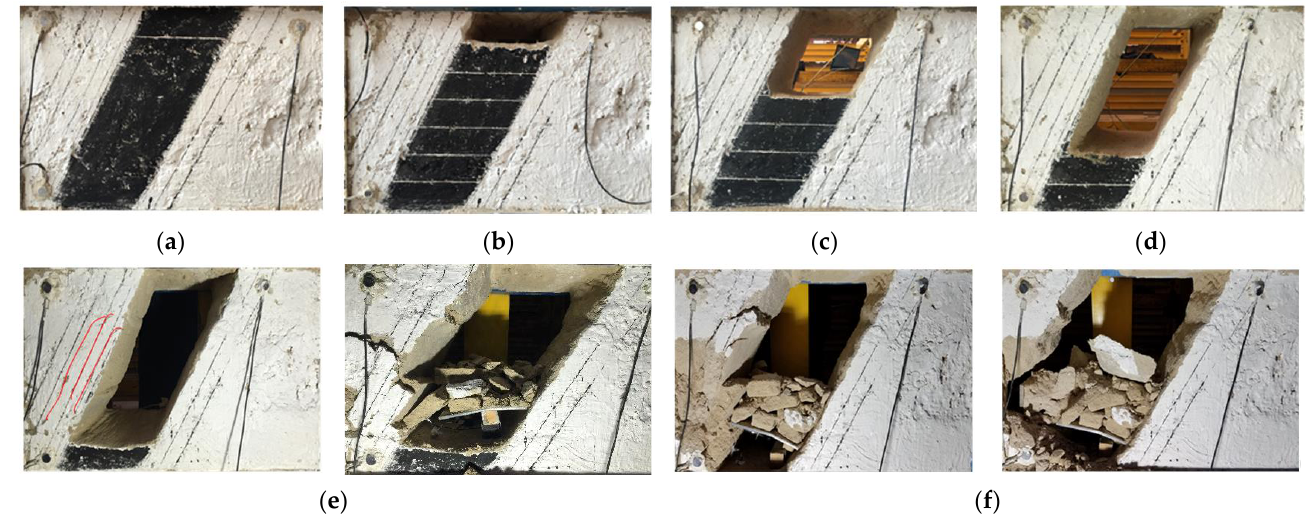
Figure 5. Model excavation process and phenomenon. ( a ) Not excavated; ( b ) Tier 1; ( c ) Tier 3; ( d ) Tier 5; ( e ) Tier 6 and Dynamic load applied to the 6th layer; ( f ) Tier 7 and Dynamic load applied to the 7th layer.